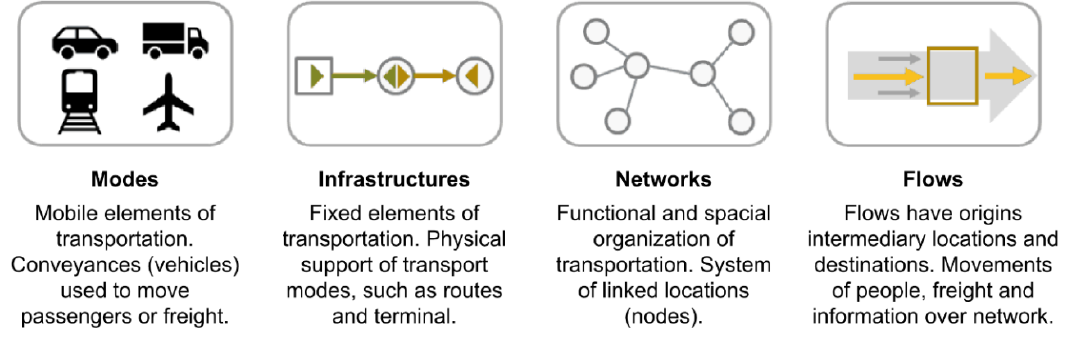
Figure 1. Components of transport modes [17].